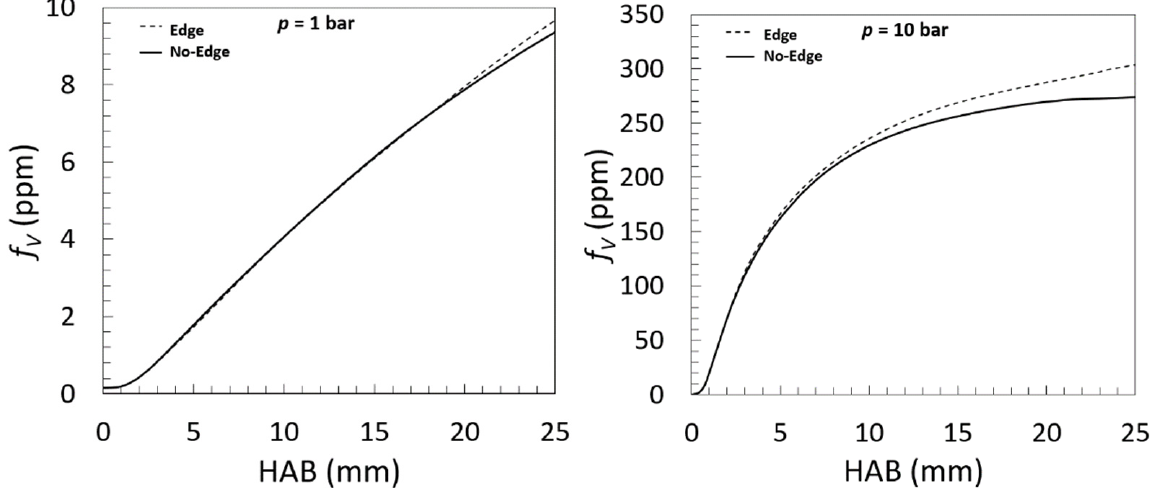
Figure 13. Predicted centerline f V (ppm) in function of HAB (mm) by 2D simulation at p = 1.01 and 10 bar of premixed flame C 2 H 4 /air ϕ = 2.1 of matrix diameter 56 mm with (dotted lines) and without edge (solid lines).